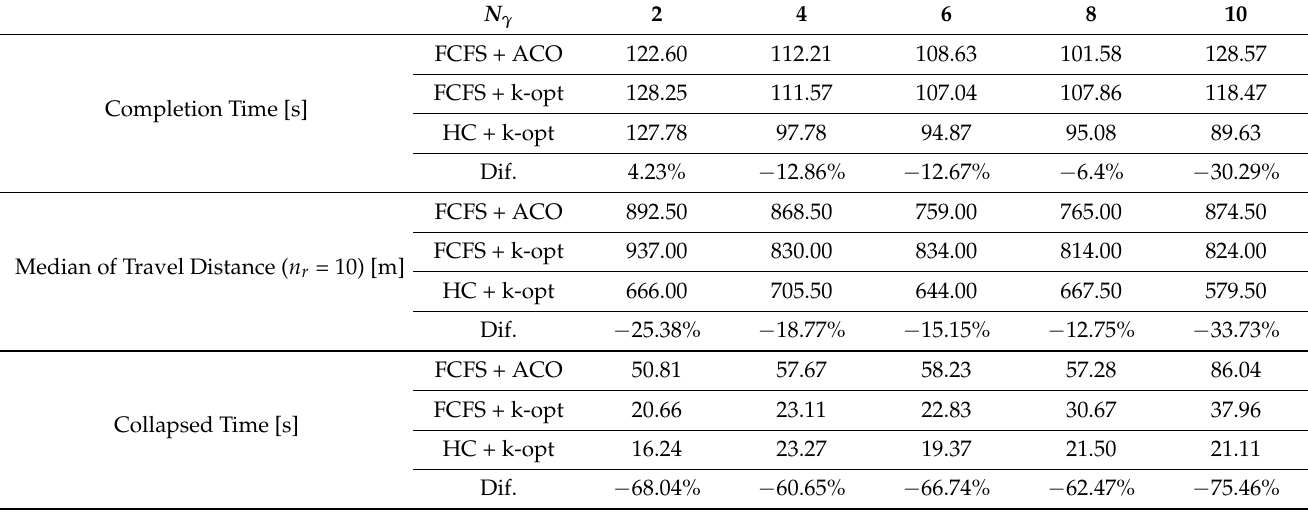
Table 2. Comparison of algorithm performance of the proposed method (HC + k-opt) for FCFS + ACO, FCFS + k-opt. Dif. means the change rate of the result of HC + k-opt with respect to the result of FCFS +